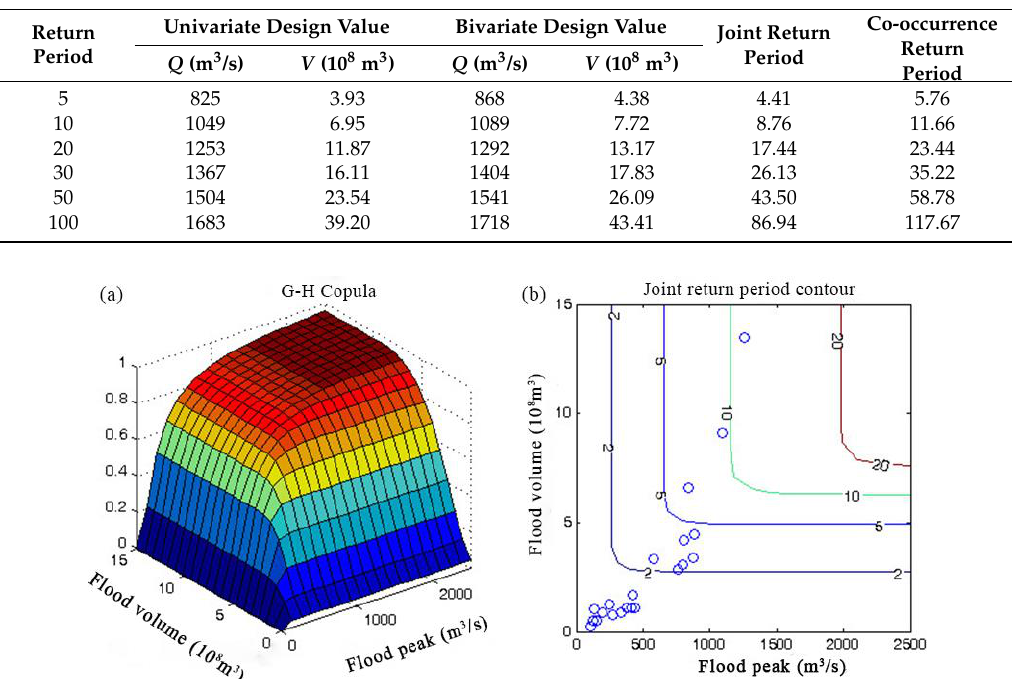
Table 8. Design value for univariate and bivariate distribution.